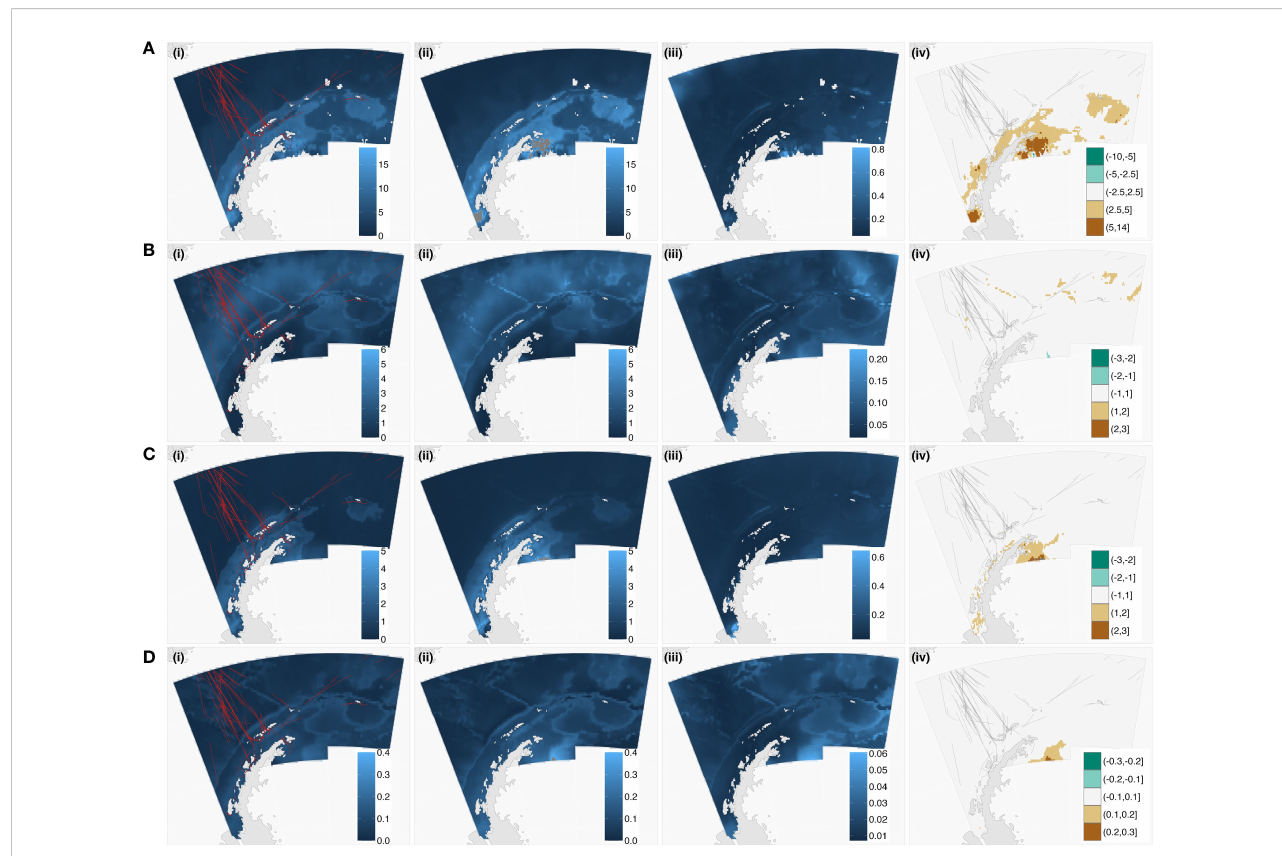
FIGURE 2 Tourist vessel-based sampling of the humpback (A) , fi n (B) , minke (C) , and blue (D) simulated whale fi elds. Plotted left to right are; (i) the simulated whale fi eld (lighter blues are the higher density of whales) and tourist vessel-based sampling (red lines), (ii) the equivalent modeled whale densities on the same color scale (noting dark grey regions are those where predictions are far greater than the original simulated whale fi eld, see Table 4 for the value ranges), (iii) grid-scale coef fi cient variations (CV) and, (iv) the true spatiality explicit differences between simulated (i) and modeled (ii) whale fi elds (scale from greens (underestimate) to white (approximately equal) to browns (overestimated)) with tourist vessel-based sampling (grey lines). These plots show the model generally predicted the spatial patterns in the original simulated whale fi elds well but performed poorly in some regions (iv). Compare grid-scale CV (iii) with true differences (iv) for inconsistencies between model output and the actual differences between the simulated and modeled grid-scale whale